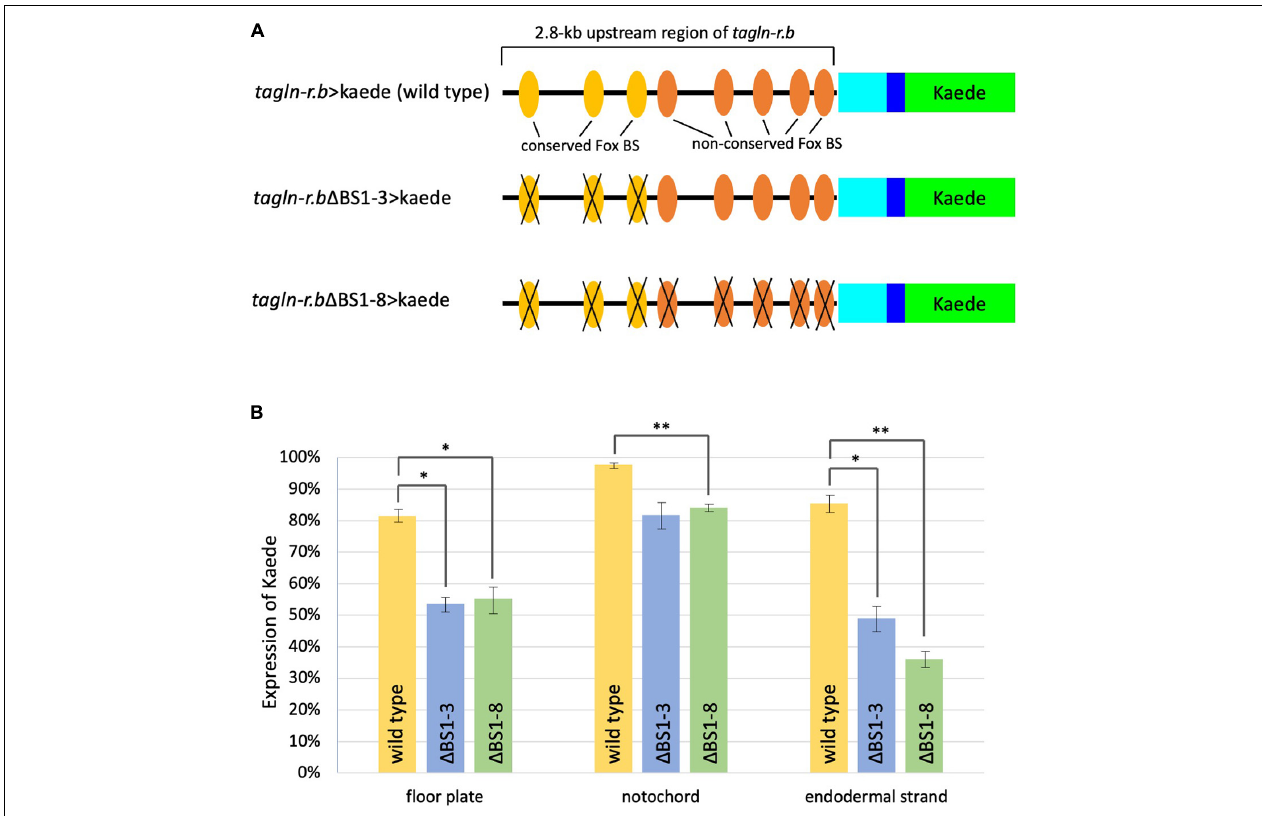
FIGURE 4 | Functional analysis of putative Fox binding sites (BSs) in the cis -regulatory region of tagln-r.b . (A) Schematic diagram of the Kaede reporter constructs. Cyan and blue boxes indicate the 5 (cid:48) untranslated region and a partial coding region, respectively, of tagln-r.b . Green boxes indicate the coding sequence of Kaede. Substitution mutations were introduced into putative Fox BSs. Colored ovals indicate the putative Fox BSs and black crosses indicate mutated BSs. (B) Expression of the Kaede reporter in the midline tissues of tailbud embryos. Localization of Kaede was detected by immunofluorescence staining in mid tailbud (12 hpf) embryos that developed from fertilized eggs electroporated with tagln-r.b > kaede fusion constructs. Vertical bars indicate the percentage of Kaede-positive embryos. Error bars represent SEM from three independent experiments. The total number of embryos scored for each construct was 172 for tagln-r.b > kaede (wild-type), 152